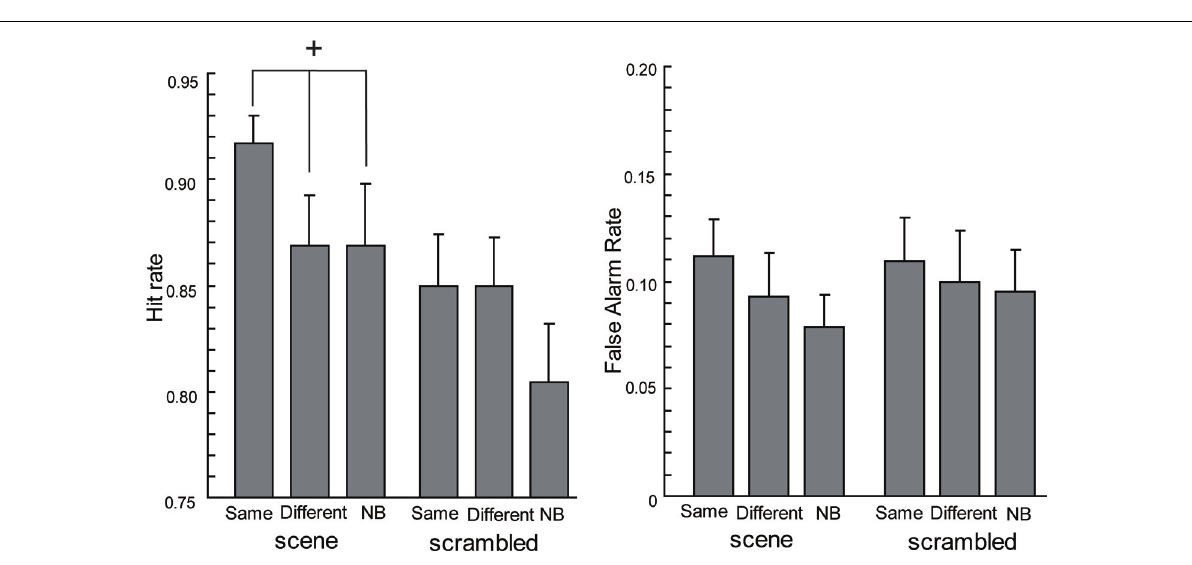
the scene condition: F (2,38) = 3.98, p < 0.05; the main effect under the scrambled condition: F (2,38) = 5.97, p < 0.01].